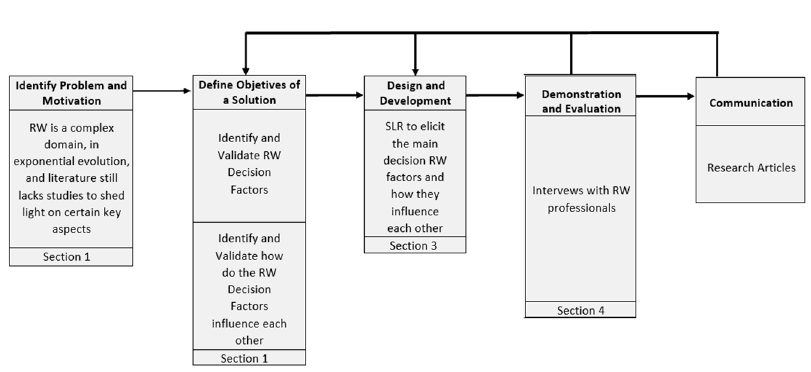
Figure 1. Diagram of the performed design science research (DSR) methodology.